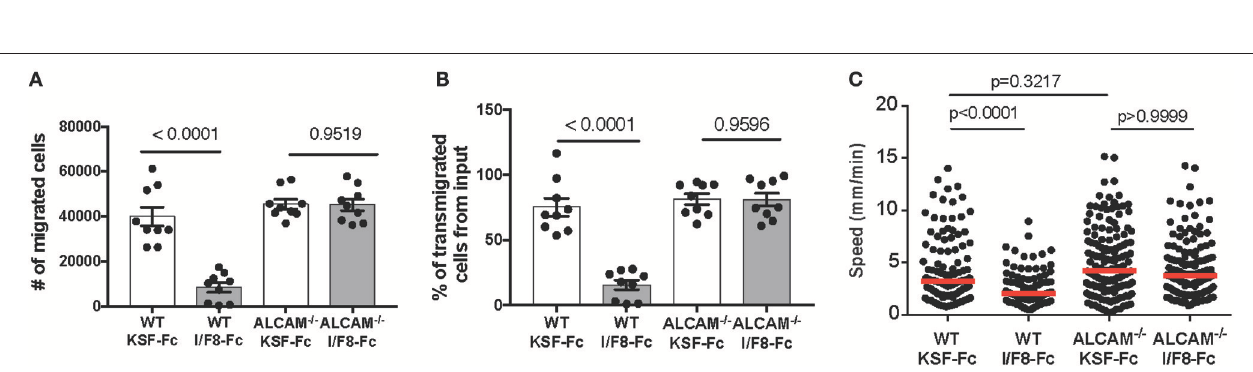
FIGURE 3 | I/F8-Fc treatment reduces developmental lymphangiogenesis in the diaphragm to a similar degree as ALCAM deficiency. (A) Schematic representation of the diaphragm and of the area analyzed by LYVE-1 immunofluorescence in D-J. TW: thoracic wall; CT: central tendon. (B) ALCAM expression on diaphragmatic P5 BECs (CD45 − CD31 + podoplanin − ) and LECs (CD45 − CD31 + podoplanin + ) was confirmed by FACS. Data from 1 out of 2 similar experiments are shown. Specific stainings are shown as black lined and isotype control stainings as gray tinted histograms. (C) Schematic presentation of the antibody treatment protocol. Pregnant mice received I/F8-Fc or KSF-Fc antibody i.p. (300 µ g) on day E15.5 and E17.5 (indicated by an asterisk). In addition, newborn mice received antibody i.p. (30 µ g) on day P1 and P3 (indicated by a circle). (D–H) On P5 the diaphragm was collected and lymphatic vessels were visualized by LYVE-1 staining. (D,E) Representative stainings from diaphragms of KSF-Fc- or I/F8-Fc-treated animals. (F–H) Image-based morphometric analysis of (F) the LYVE-1 + area, (G) the number of branch points and (H) the total vessel length in the diaphragm of I/F8-Fc or KSF-Fc control-treated pups. Each dot represents the measurement made in one animal ( n = 10). Data from 1 out of 3 similar experiments are shown in F-H. (I,J) Image-based morphometric analysis of (I) the number of branch points and (J) the total vessel length in the P5 diaphragm of WT and ALCAM − / − mice. Data from 1 experiment ( n = 6 or 9 mice) are shown in G-H. KSF-Fc: control antibody. I/F8-Fc: anti-ALCAM.